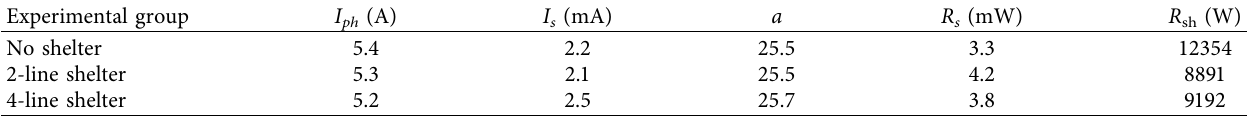
Table 3: Result of parameter identification.